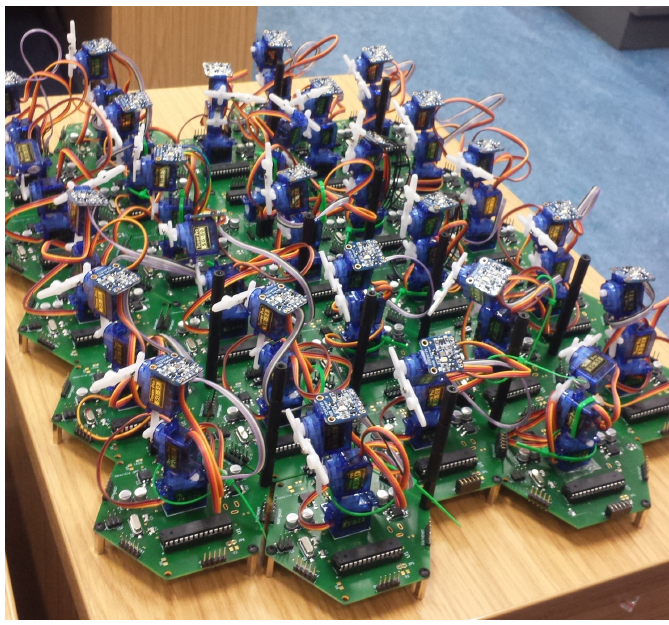
Figure 6. Multiple-tiled hexagonal cilia connected to each neighbour, sharing power and